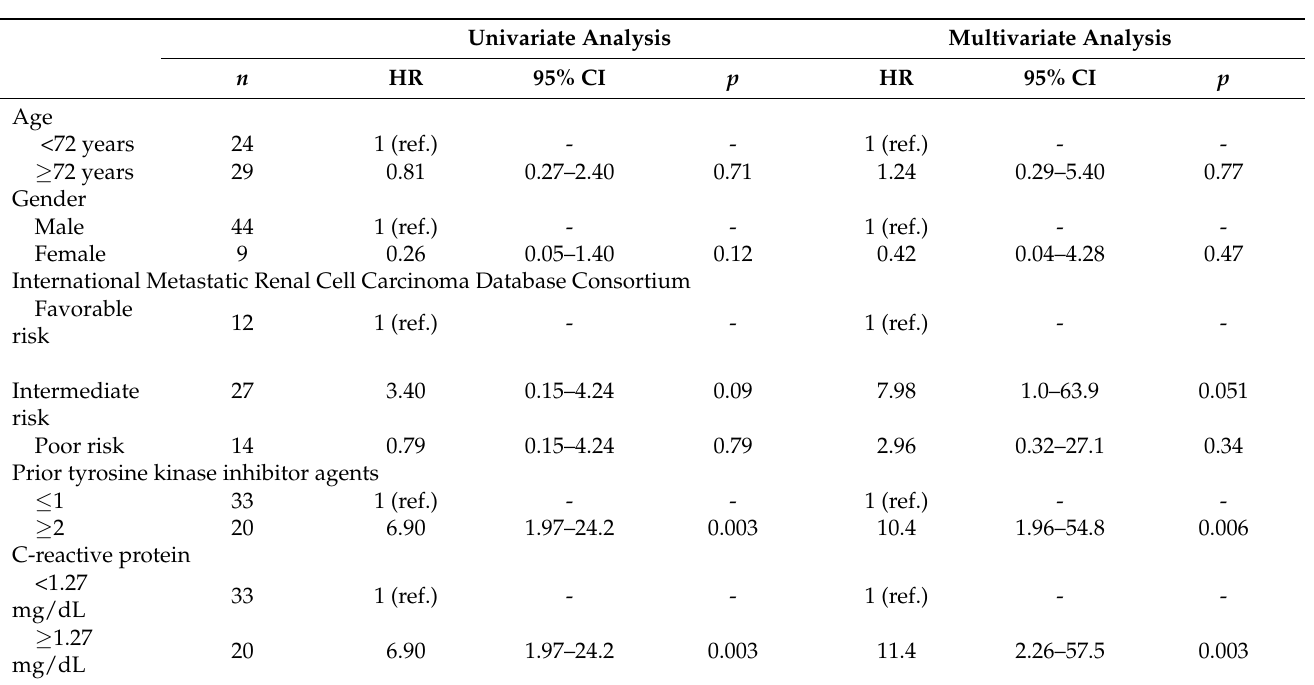
Figure 2. Progression-free survival (PFS) for cabozantinib in patients with advanced or metastatic renal cell carcinoma. ( A ) PFS for cabozantinib stratified by the number of prior tyrosine kinase Table 3. Univariate and multivariate analyses of clinical parameters for the prediction of progression-free survival.